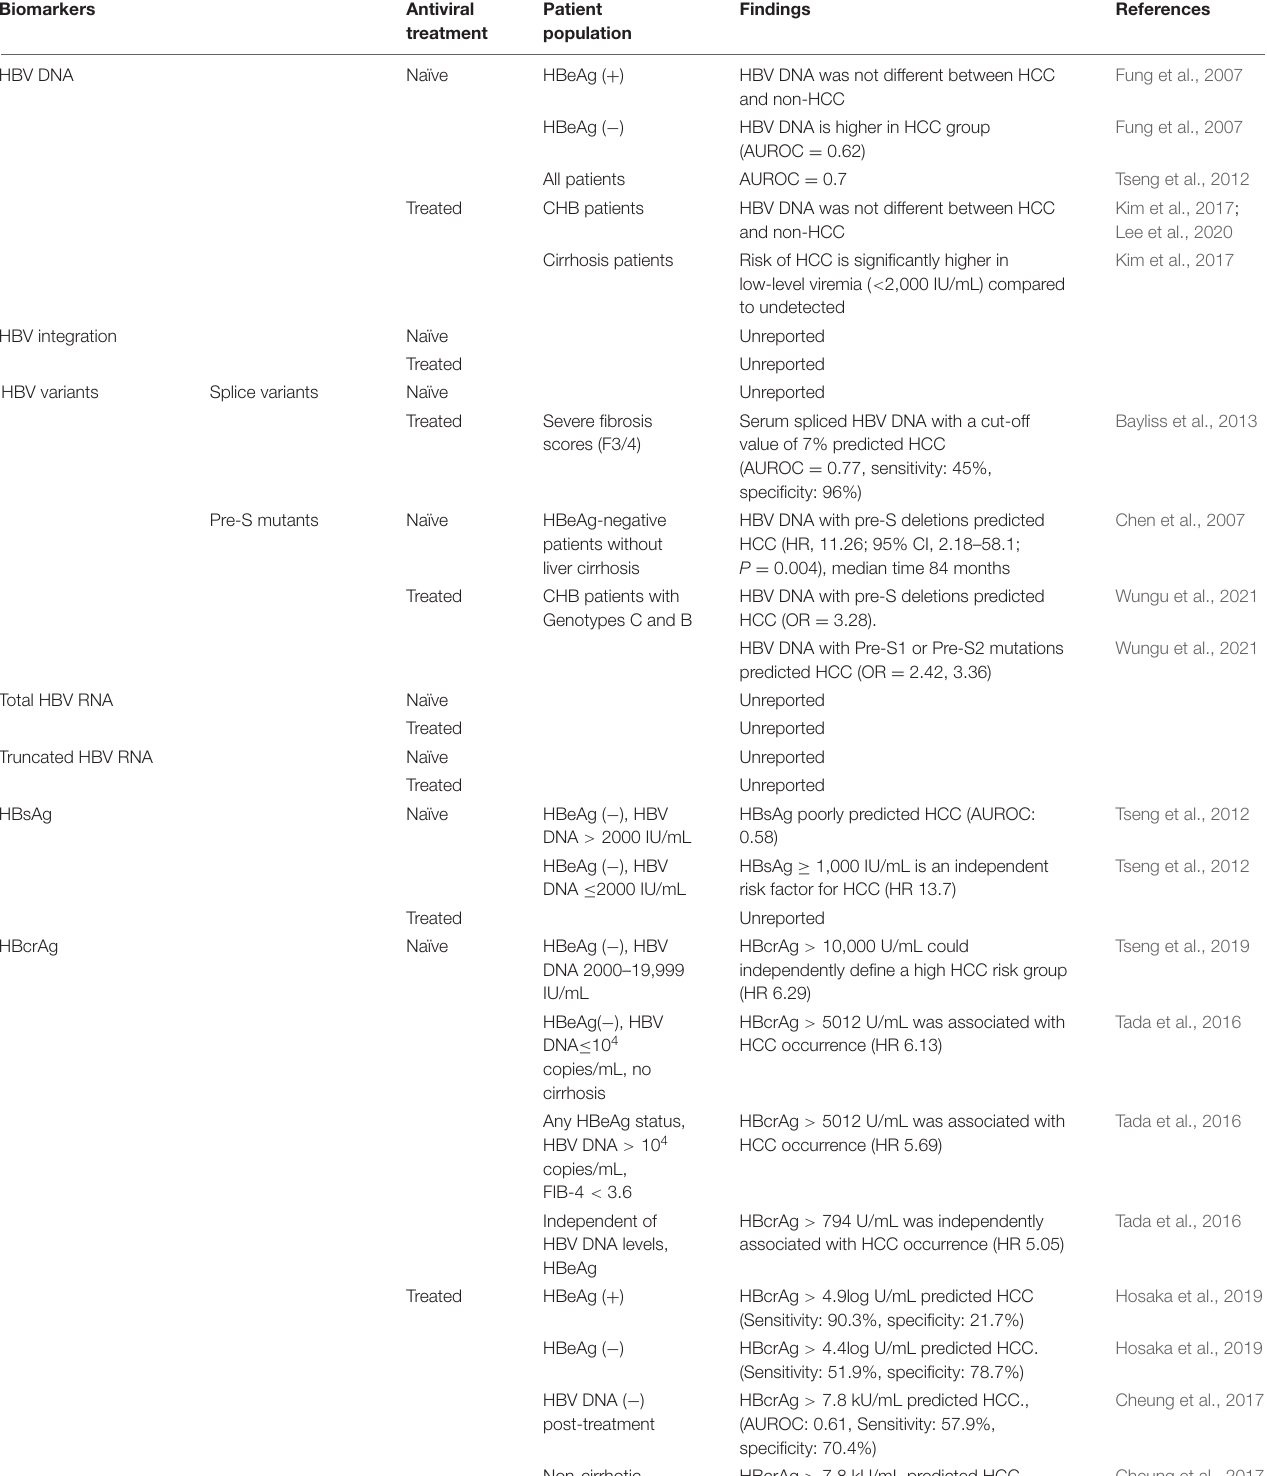
TABLE 2 | Serum viral biomarkers for the prediction of HCC occurrence.